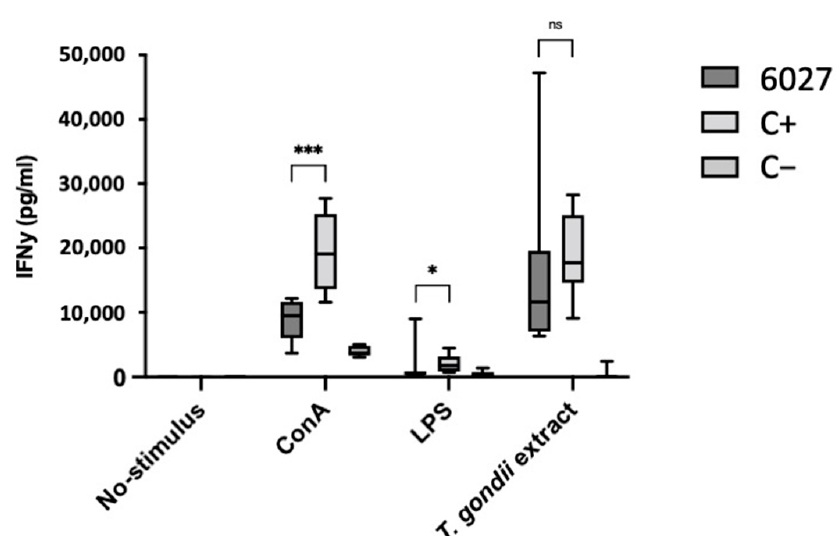
Figure 4. Cerebral parasite load ( A ) and IgG-titers ( B ) in CD1 mice infected with T. gondii oocysts and either treated with peptide 6027 (3 mg/kg/day for 5 days) or treated with placebo only (C+). C − was not infected and only placebo treated; * indicates p < 0.05; ns = not significant. IFN- γ responses of spleen cells to ConA stimulation were lower in splenocyte cul- tures of the peptide 6027 group compared to the other groups ( p = 0.0001), while no or only very little IFN- γ was measured in the supernatants of LPS-stimulated spleen cells ( p = 0.0207). However, no difference in IFN- γ production was noted when splenocytes were stimulated with T. gondii extract ( p = 0.1949) (Figure 5). Overall, this experiment showed that in vivo treatment did not mirror the excellent in vitro efficacy results and that peptide 6027 treatment was not only ineffective but also exacerbated T. gondii infection.